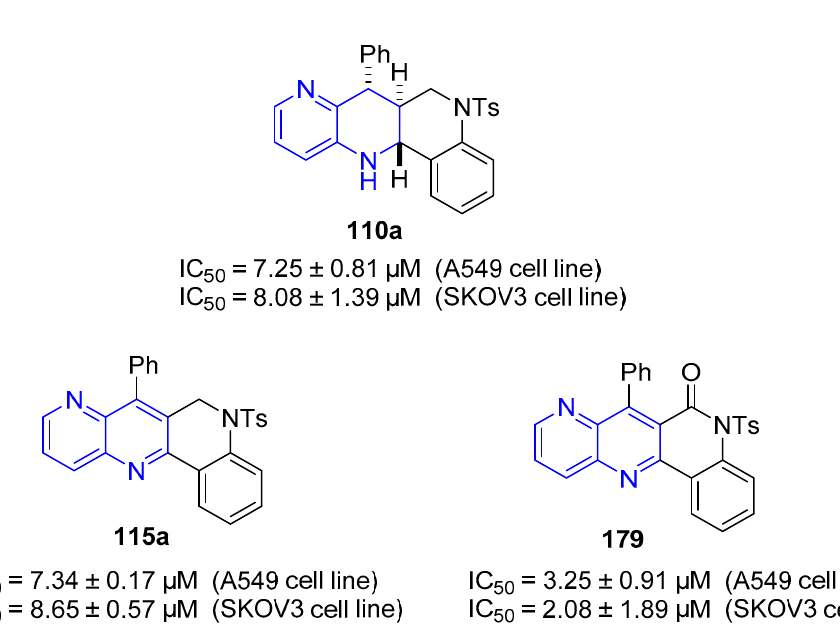
Figure 11. Cytotoxic activity of 110a , 115a , and 179 on A549 and SKOV3 cell lines.